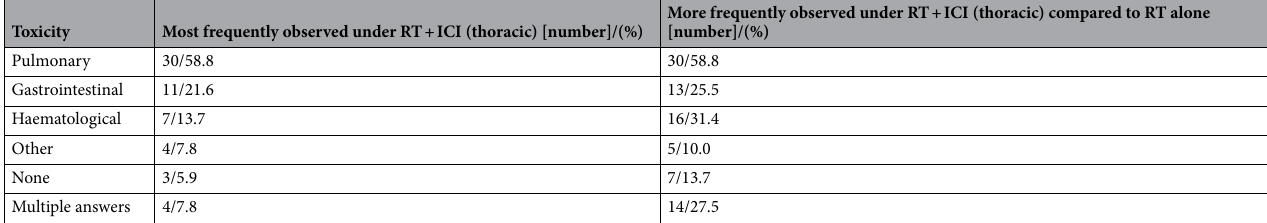
Table 3. Toxicity observed for thoracic radioimmunotherapy with Immune Checkpoint Inhibitors (RT + ICI) and radiation therapy (RT) alone. Data is given in absolute number of answers and in percentage of the number of participants (N = 51).